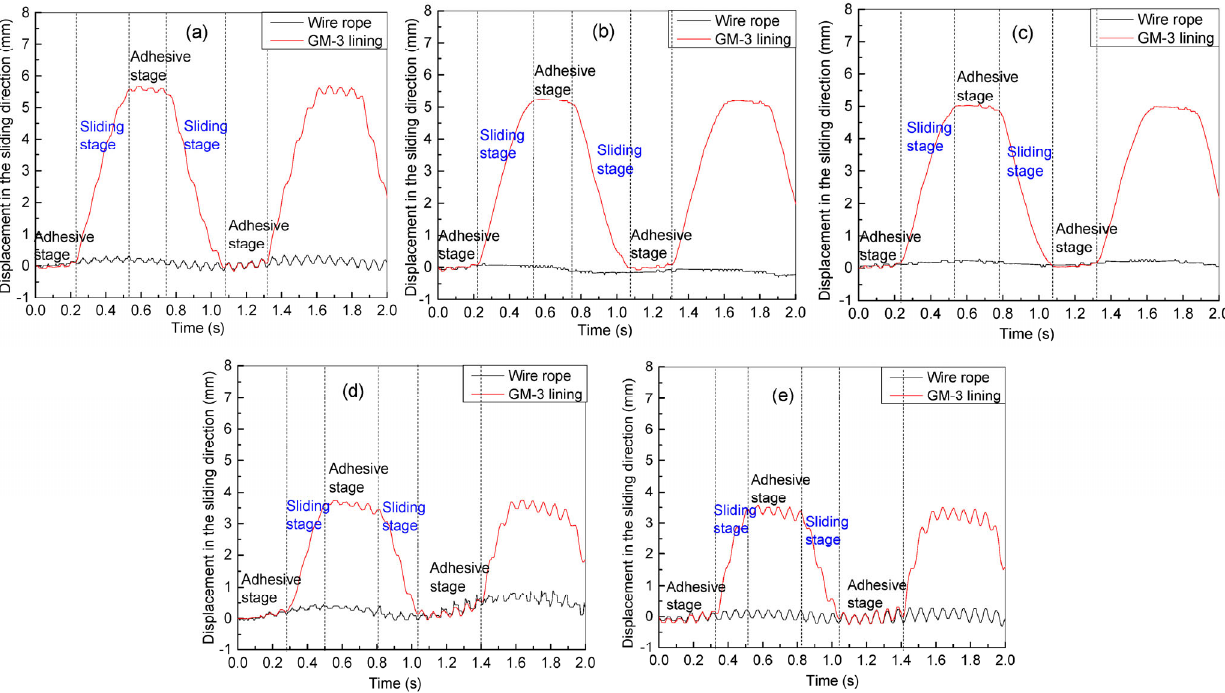
Fig. 7 Displacement of the G30 lining and wire rope in the sliding direction at: (a) 1, (b) 1.5, (c) 2, (d) 2.5, and (e) 3 MPa.